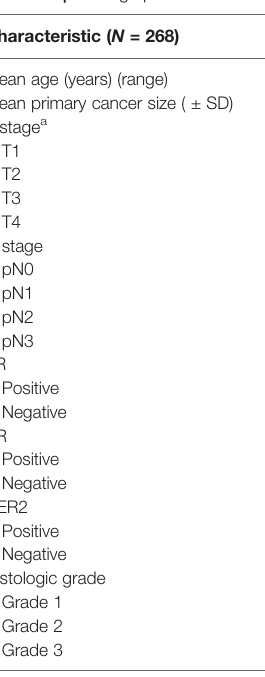
TABLE 1 | Demographics and tumor